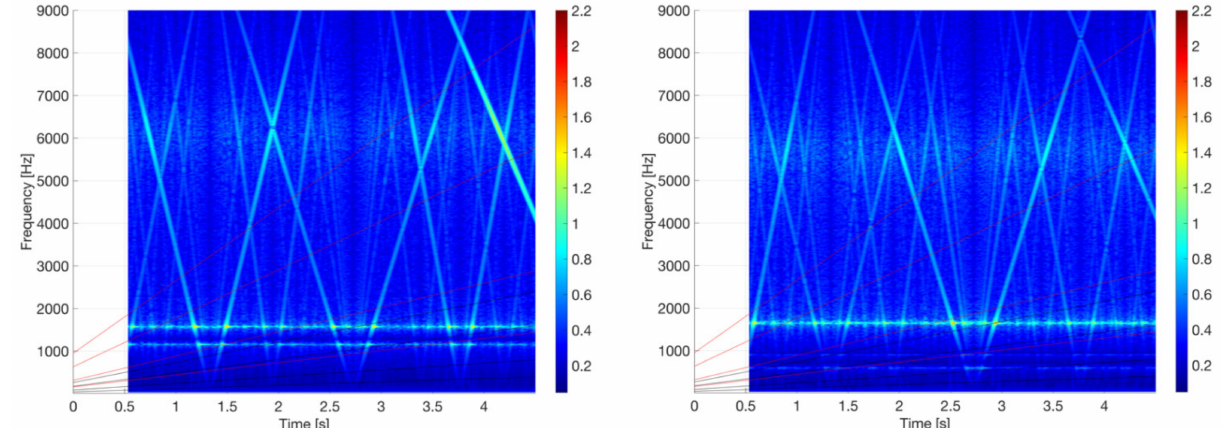
Figure 9. Spectrogram of tangential displacement on node 1 on the left for the solid web, on the right for the flexible web. The red and black sloped lines represent the harmonics of the meshing frequency of, respectively, pinion (red) and gear (black). The yellow circle indicates the crossing between a natural frequency and a harmonic of meshing frequency. Colormap reports the amplitude of the (cid:112) √ response and the unit is mm, this due to the little value of the